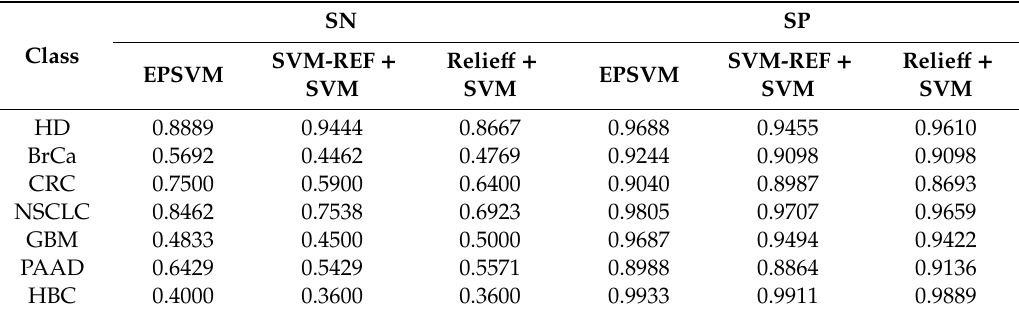
Table 8. SN and SP of dataset 14 for each class (  = 0.5).